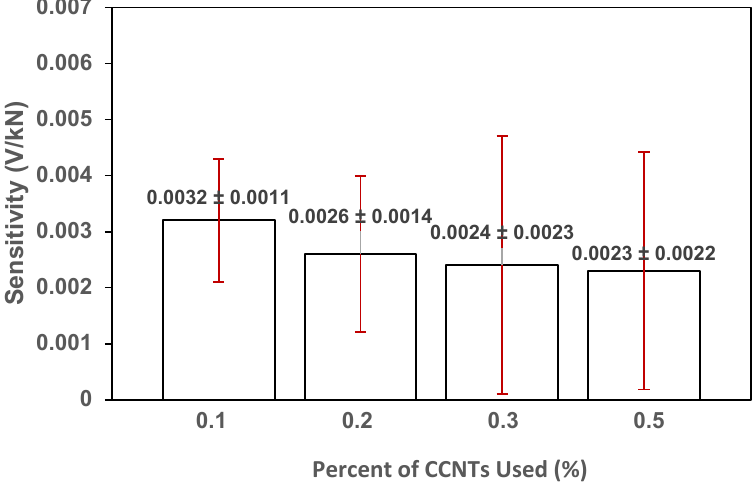
Figure 11. Average piezo-sensitivity in samples with different concentration of CCNTs. The vertical error bars represent the standard deviations.